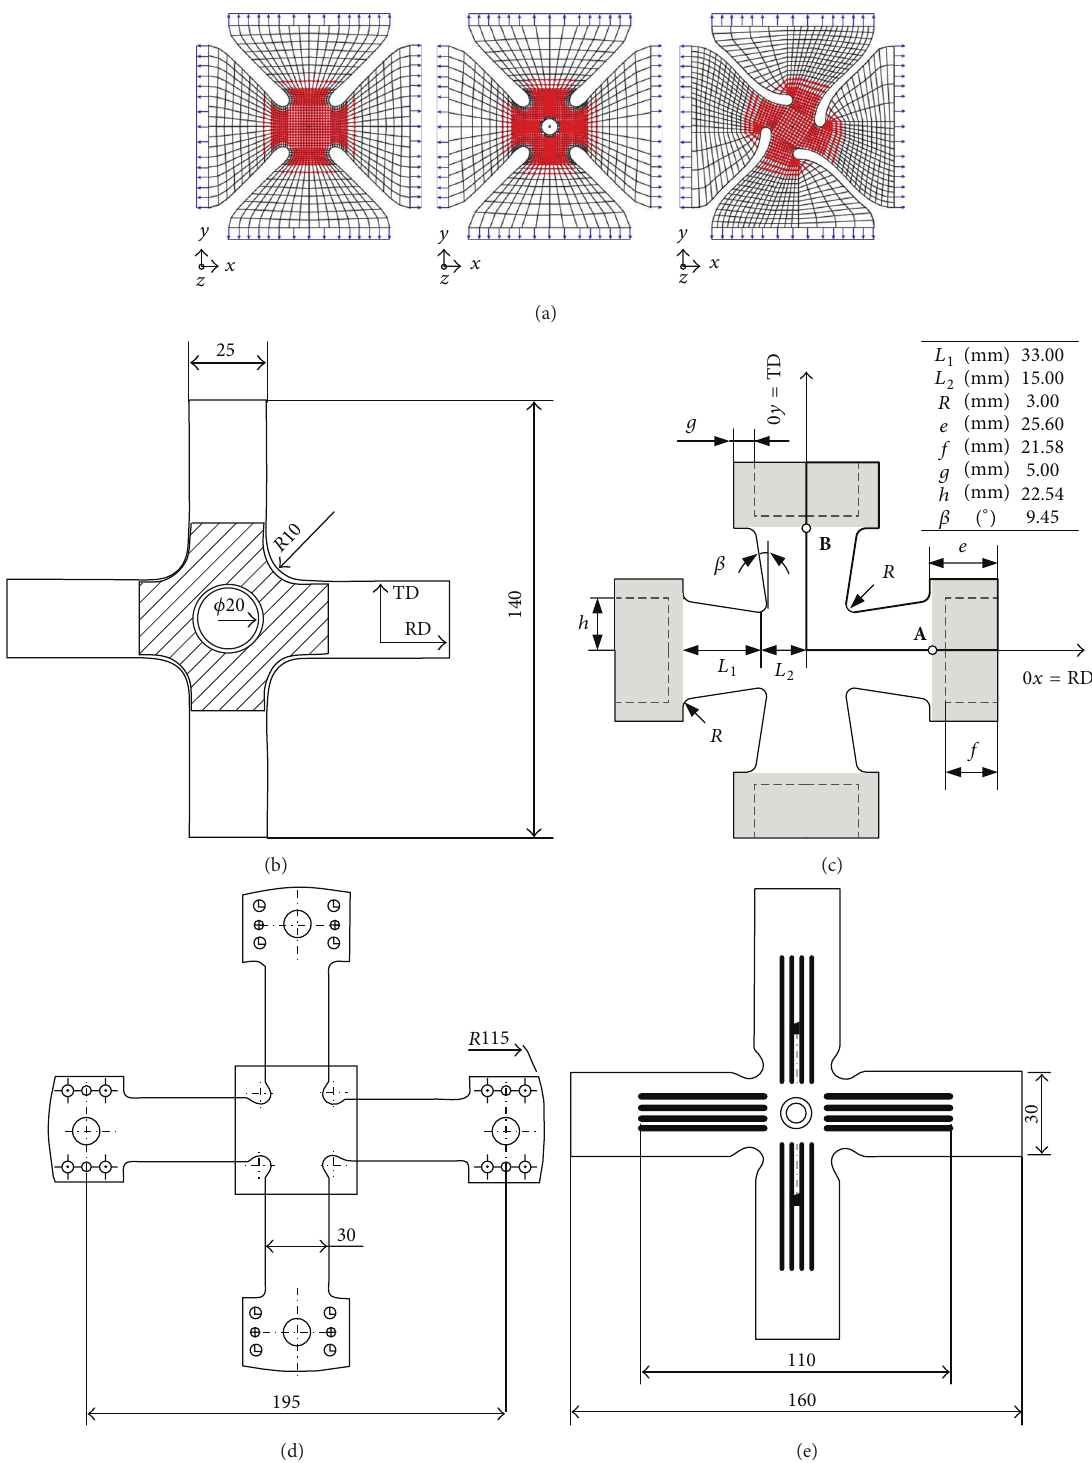
Figure 3: Cruciform specimen geometries proposed in the literature for FEMU strategies: (a) Schmaltz and Willner [24]; (b) Cooreman et al. [21]; (c) Prates et al. [25, 26]; (d) Zhang et al. [27, 28]; and (e) Liu et al. [29].